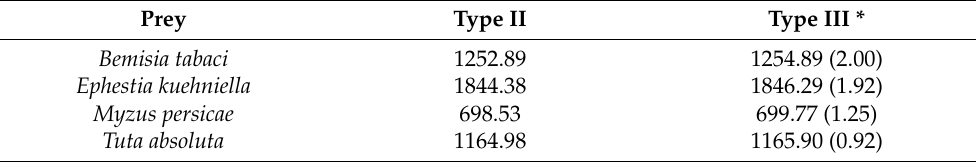
Table 6. Akaike information criterion (AIC) for the two candidate functional response models for each prey ( Bemisia tabaci 4th instar nymphs, Ephestia kuehniella eggs, Myzus persicae 1st instar nymphs or Tuta absoluta eggs).